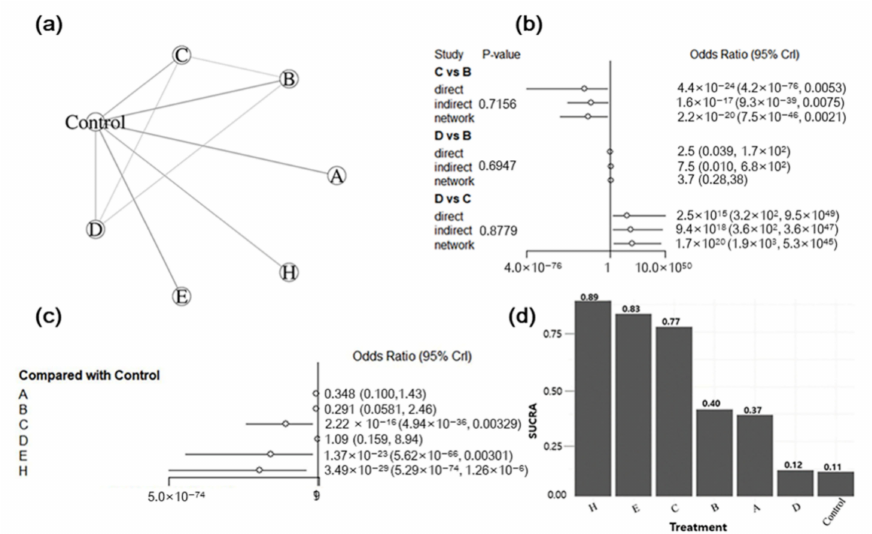
Figure 7. Results of the network meta-analysis of ETEC vaccines on mortality outcome. ( a ) Network graph for eligible treatment comparisons; each node represents one type of vaccine, the line connecting two nodes (edge) represents the evidence from direct treatment comparisons, and the edge thickness indicates how often treatments were compared in the primary trials. ( b ) Node split results for the assessment of inconsistency; ( c ) forest plot presenting the effectiveness of vaccines when compared with the control group; ( d ) SUCRA for each vaccine from the best to worst.